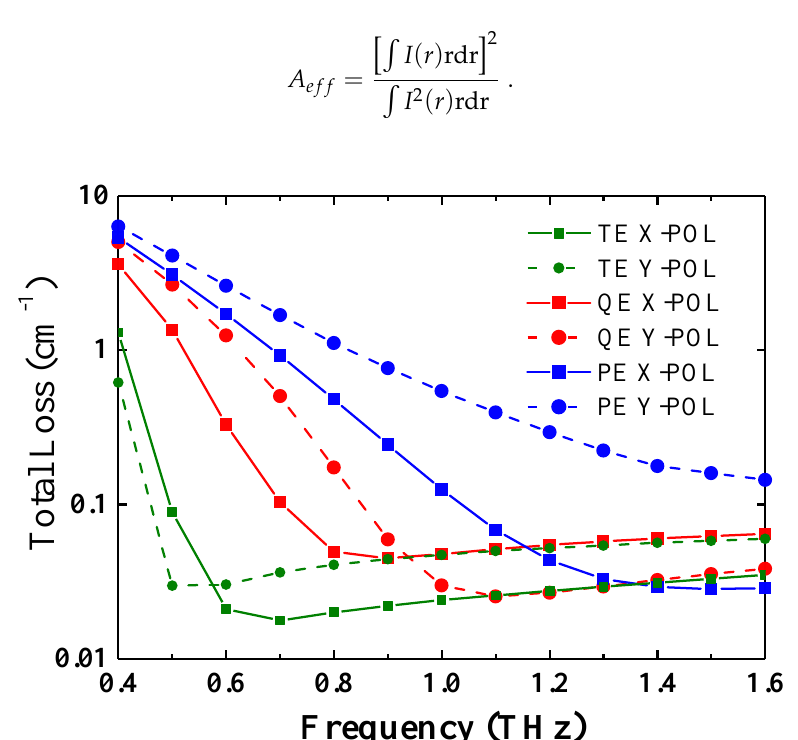
Figure 8. Response of total loss to frequency for the TE, QE, and PE designs.